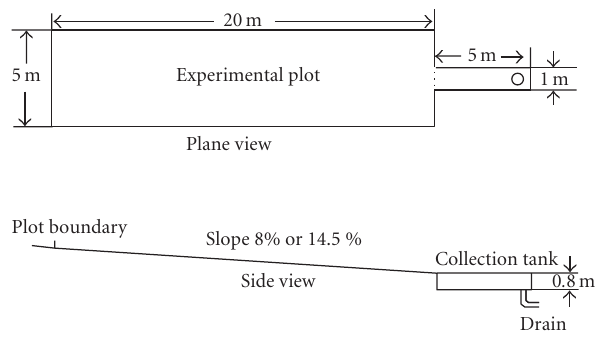
Figure 1: Location of the experimental site and the layout of the experimental plots.